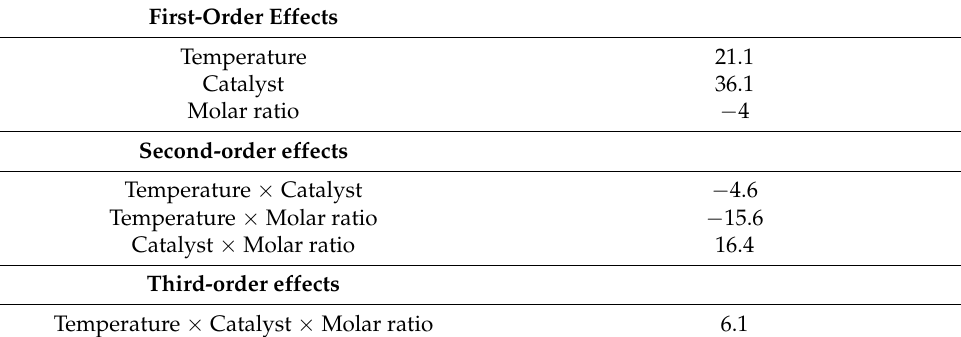
Table 9. Effects variables to 2 3 planning.